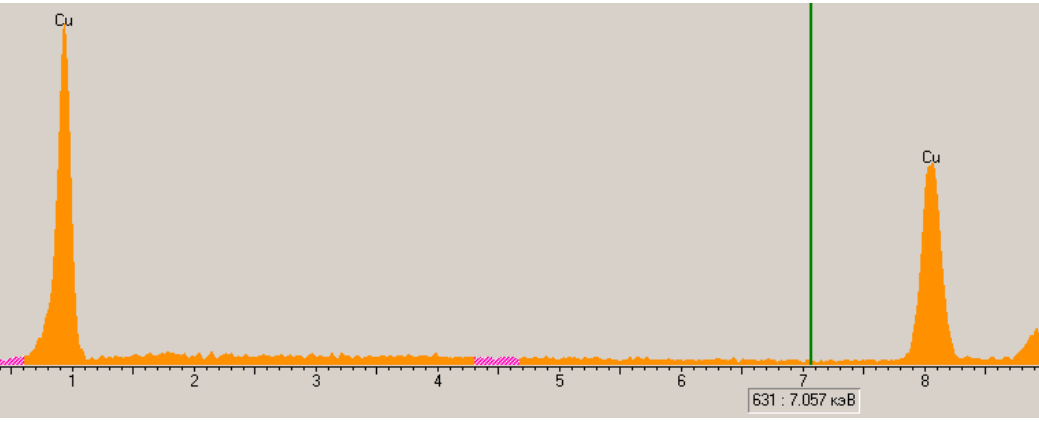
Figure 14. The spectrum of characteristic X-rays of the surface of copper polypropylene.